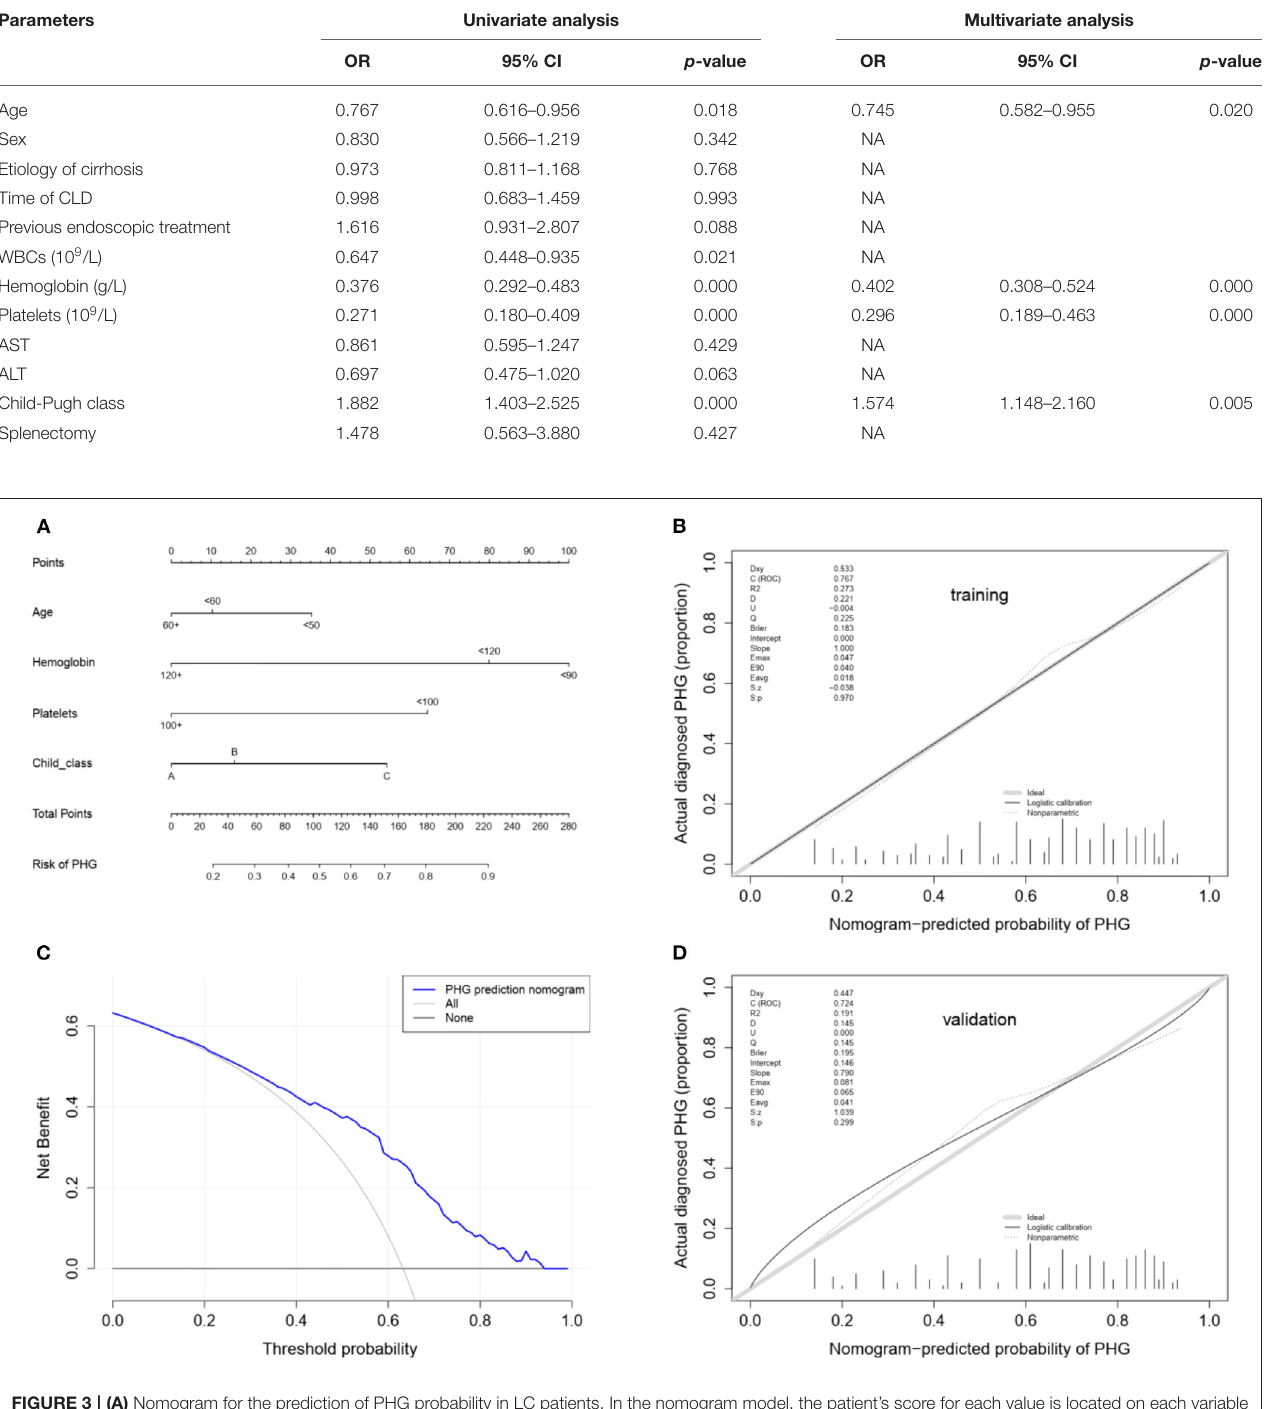
TABLE 5 | Logistic regression analysis on the training cohort.